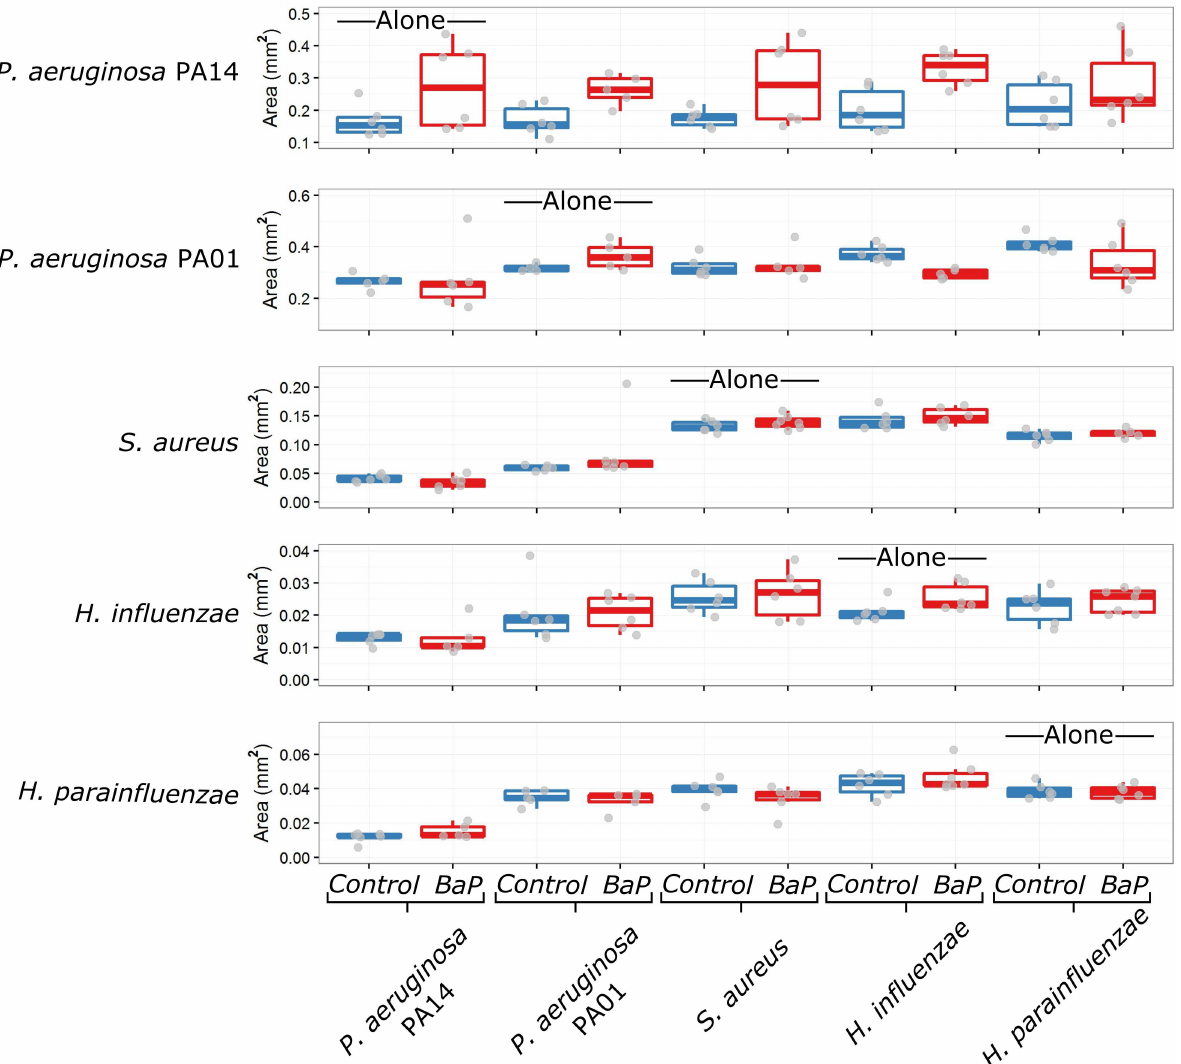
Fig 3. Final colony areasacross all conditions. Colonyareas were obtainedfrom the images using semi-automated image analysisin CellProfiler. Areas were convertedfrom pixels to mm 2 based on images of paper standards. Controlconditionsare shown in blue while BaP conditions are shown in red. Individual data points are shown in gray (note that some outliers are outside the axis range of these plots). The colony areas correspond to the species labels on the left, whilethe labels along the bottom indicatethe pairedspecies. Species interactions are inferred by comparing pairwisegrowth with growth alone. For example,notice that when grown next to P . aeruginosa PA14, all the other speciesreach smaller colony areas than when grown alone, suggestingthat P . aeruginosa PA14 negatively interacts with all four other